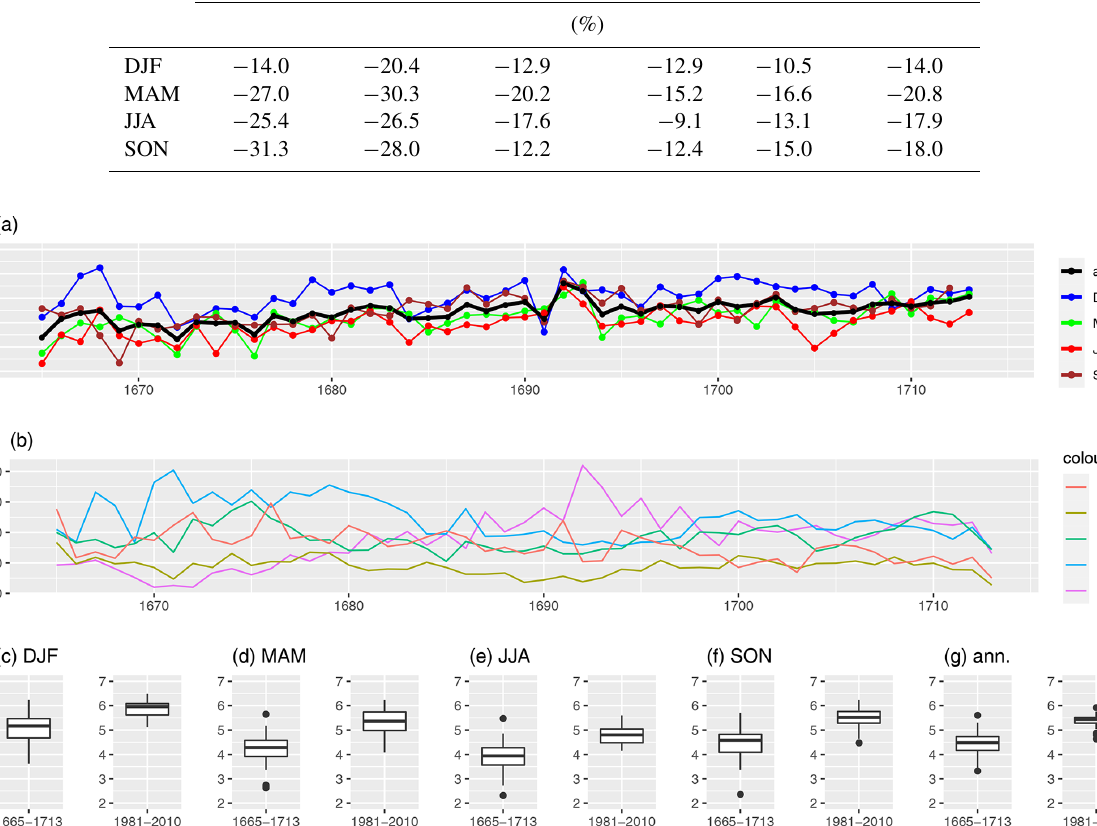
pearances per height (Hahn et al., 2001; Wu et al.,